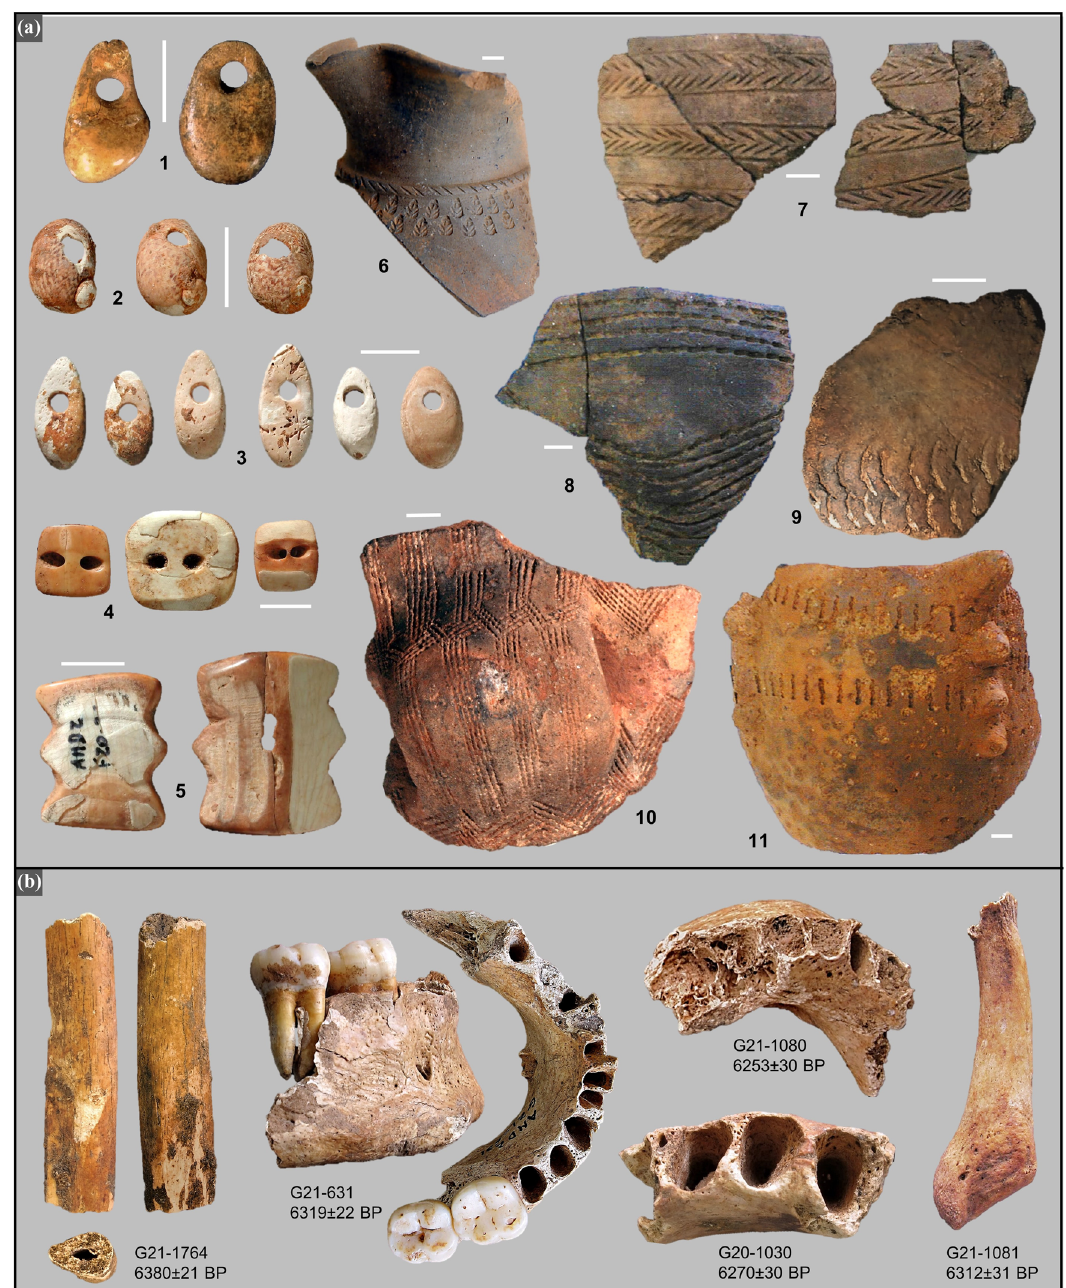
Figure 2: Galeria da Cisterna. The Holocene context in zones AMD2 and AMD3. ( a ) Pottery and beads ( the white scale bars associated with each item or group of items represent 1 cm ) . 1. Perforated red deer canine and bone bead imitation; 2. perforated shells ( Theodoxus fl uviatilis ) ; 3. teardrop beads ( Glycymeris sp. ) ; 4 and 5. sperm - whale ivory buttons; 6. stamped pot; and 7 – 11. impressed ceramics ( 1 – 3, 7 – 11: Early Neolithic; 4 and 5. Bell Beaker; 6. Iron Age ) . ( b ) The human bone remains providing the MNI for the Cardial burials ( not to scale )